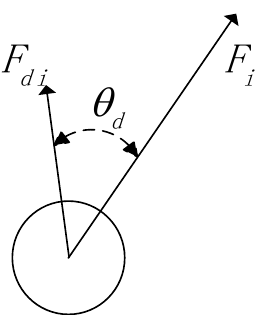
Figure 4. Schematic diagram of rotating potential